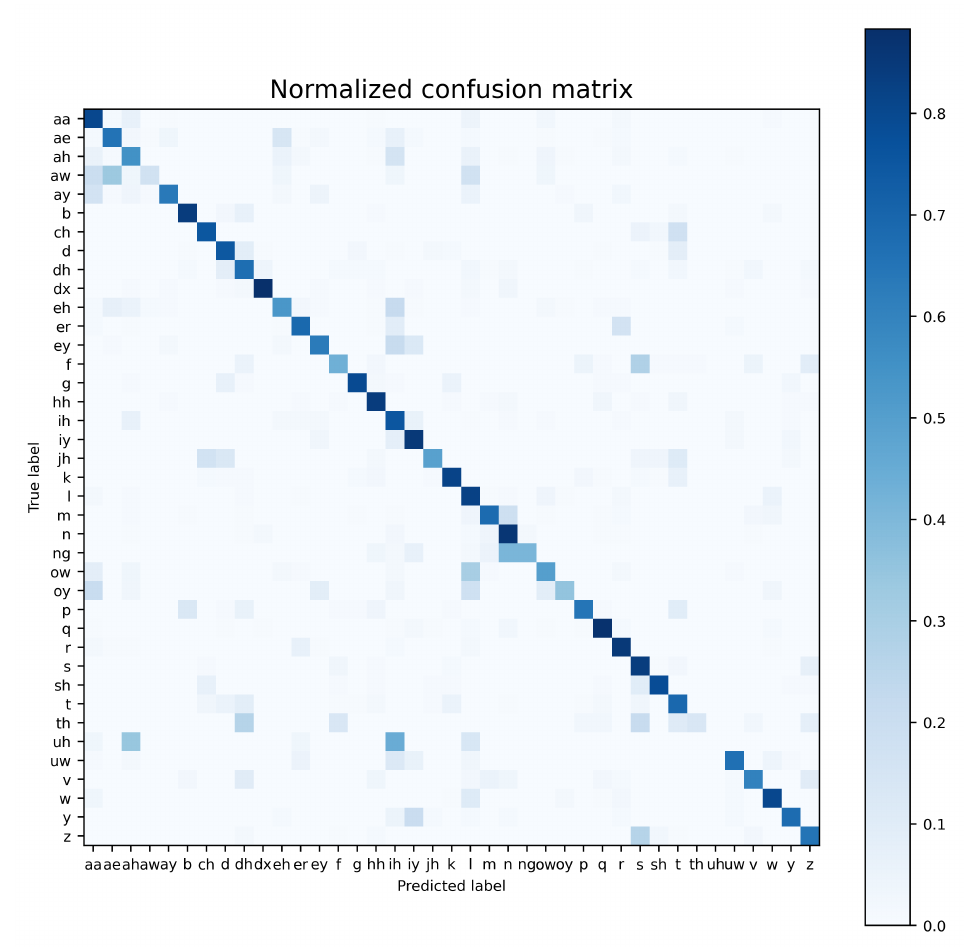
Figure 7. Confusion matrix for the best-performing simple CNN architecture ( N FB = 128, WL = 256, n DFT = 256), trained using the proposed, ‘central’ examples.